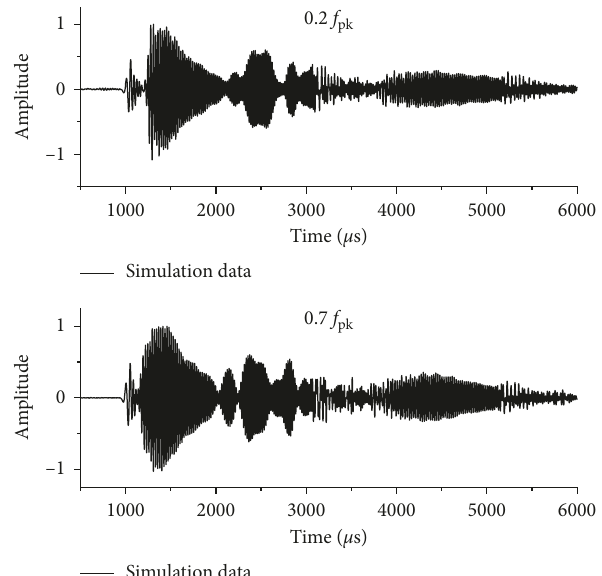
Figure 5: Finite element simulation of the guided wave